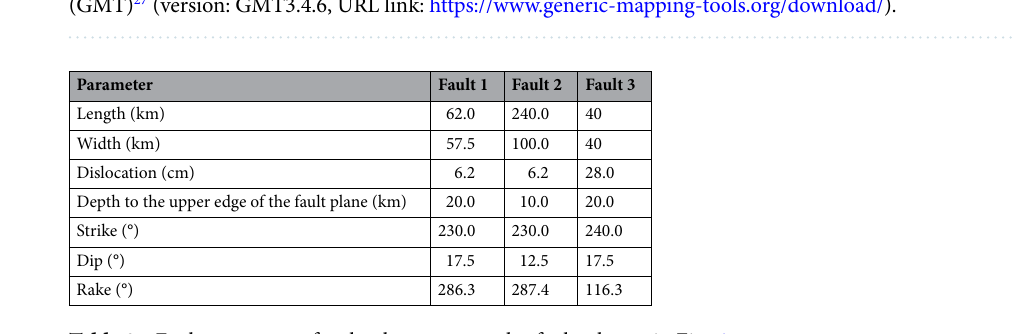
Table 2. Fault parameters for the three rectangular faults shown in Fig.